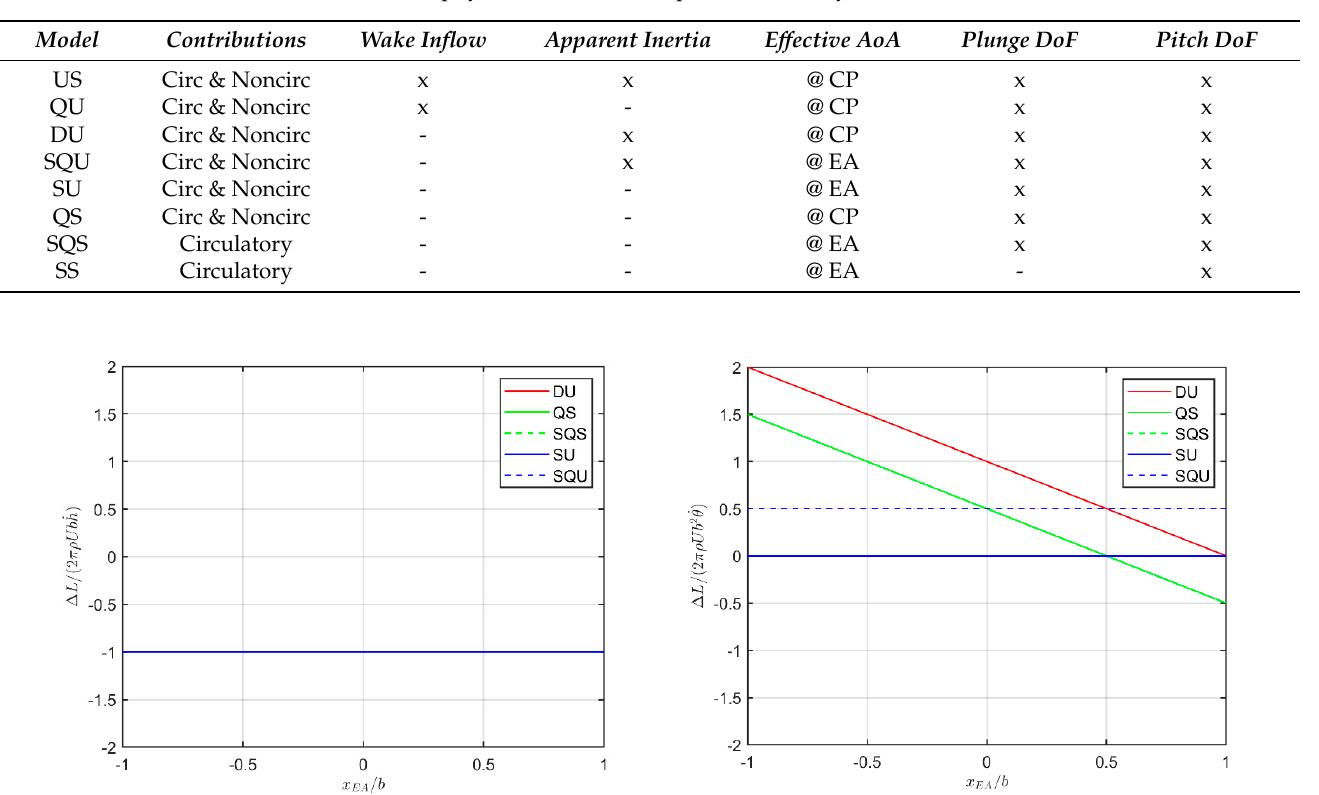
Figure 1. Normalised aerodynamic damping derivatives for the aerofoil’s lift: plunge rate ( left ), pitch rate ( right ).